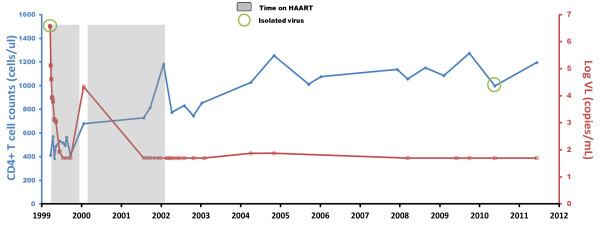
Clinical characteristics of Patient 169. The patient's CD4 counts and viral load are shown. Viral load measurements below the limit of detection are denoted by open symbols. The time on HAART is denoted by the shaded region.